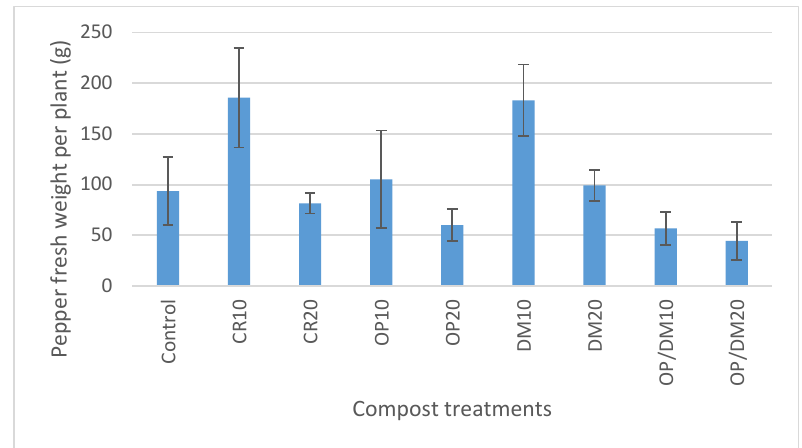
Figure 10. SPAD absorbance on 23 August 2018 as affected by different compost sources and rates. Error bars represent ± standard error ( P = 0.159, n = 6).